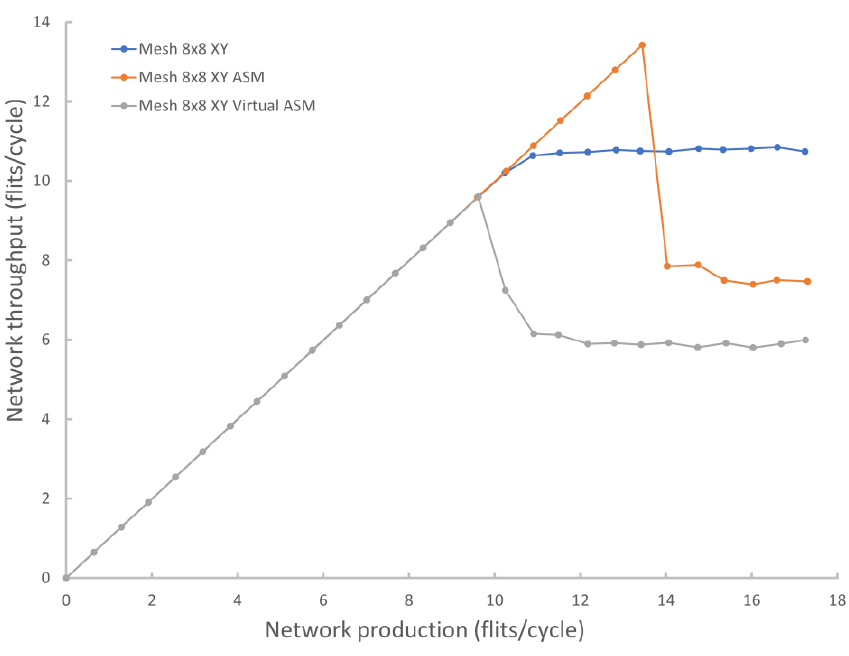
Figure 5. Comparison of throughput of virtual and physical subnetworks when using ASM.